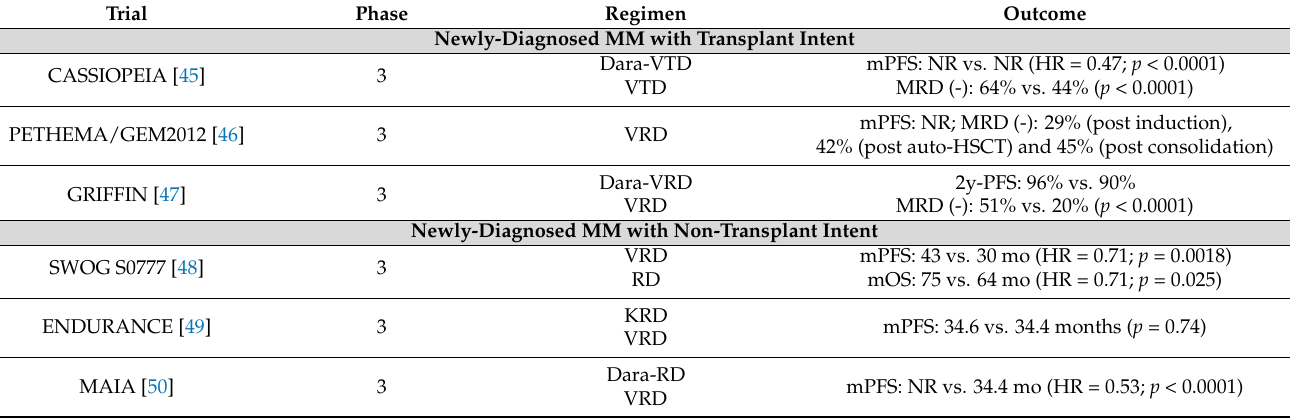
Table 1. Summarize the results of randomized clinical trials with